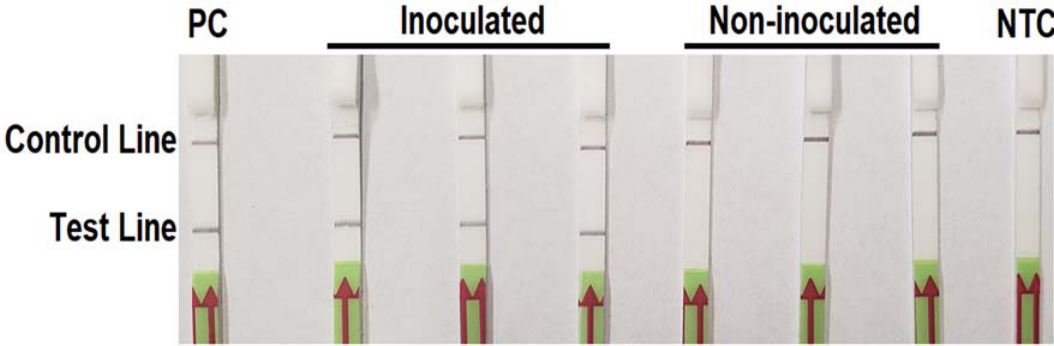
Figure 5. Detection of Phytophthora cinnamomi in artificially inoculated pine needles of Cedrus deodara using the recombinase polymerase amplification ‐ lateral flow dipstick assay. Genomic DNA (10 ng per μ L) of P. cinnamomi isolate Pci1 was used as the positive control (PC). Nuclease ‐ free water was used in place of DNA templates in the no template control (NTC). Dipsticks of the first repeat are shown. Identical detection results were observed in the second repeat of the experiment.